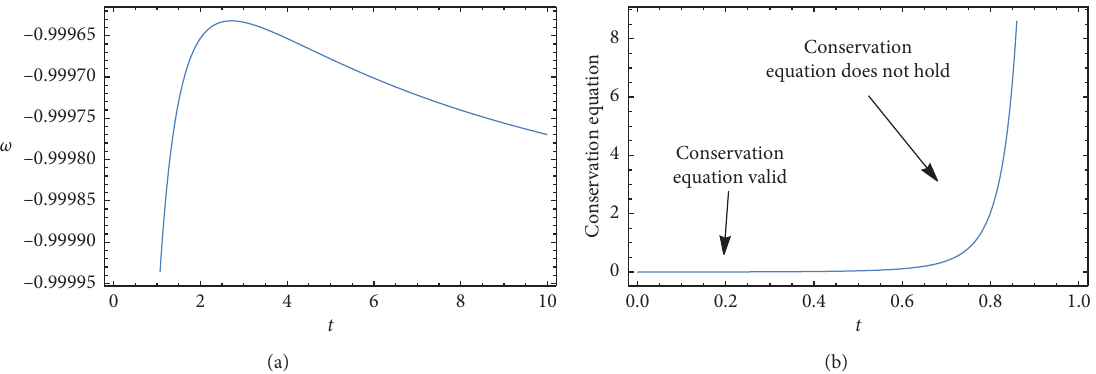
Figure 5: Evolution of Hubble and deceleration parameters for ω ζ � 0 . 01 ; ξ � 0 . 01 ; k � − 0 . 001 ; β � 0 . 005 ; λ � 0 . 005.